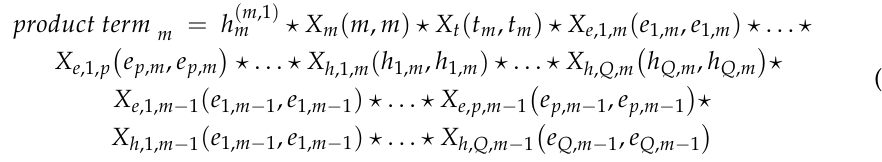
(cid:0) (cid:1) (cid:0) (cid:1) h 1, m ,..., h Q , m h 1, m − 1 ,..., h Q , m − 1 and values h m − 1 = at